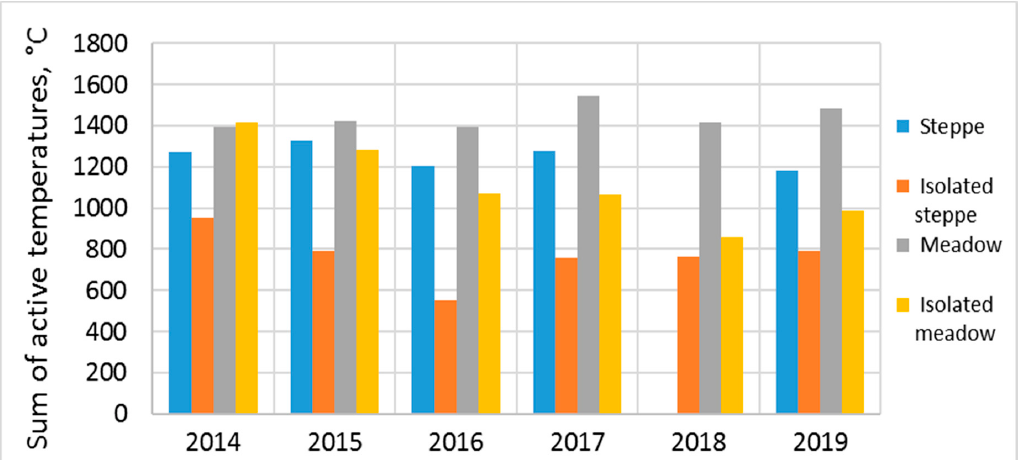
Figure 7. The change in the sum of active temperatures (above 10 ° С ) at a depth of 0.2 m. The F-ratio value is 38.30557. The p -value is < 0.00001. The result is significant at p < 0.05. The penetration depth of active temperatures largely depends on the thermophysical